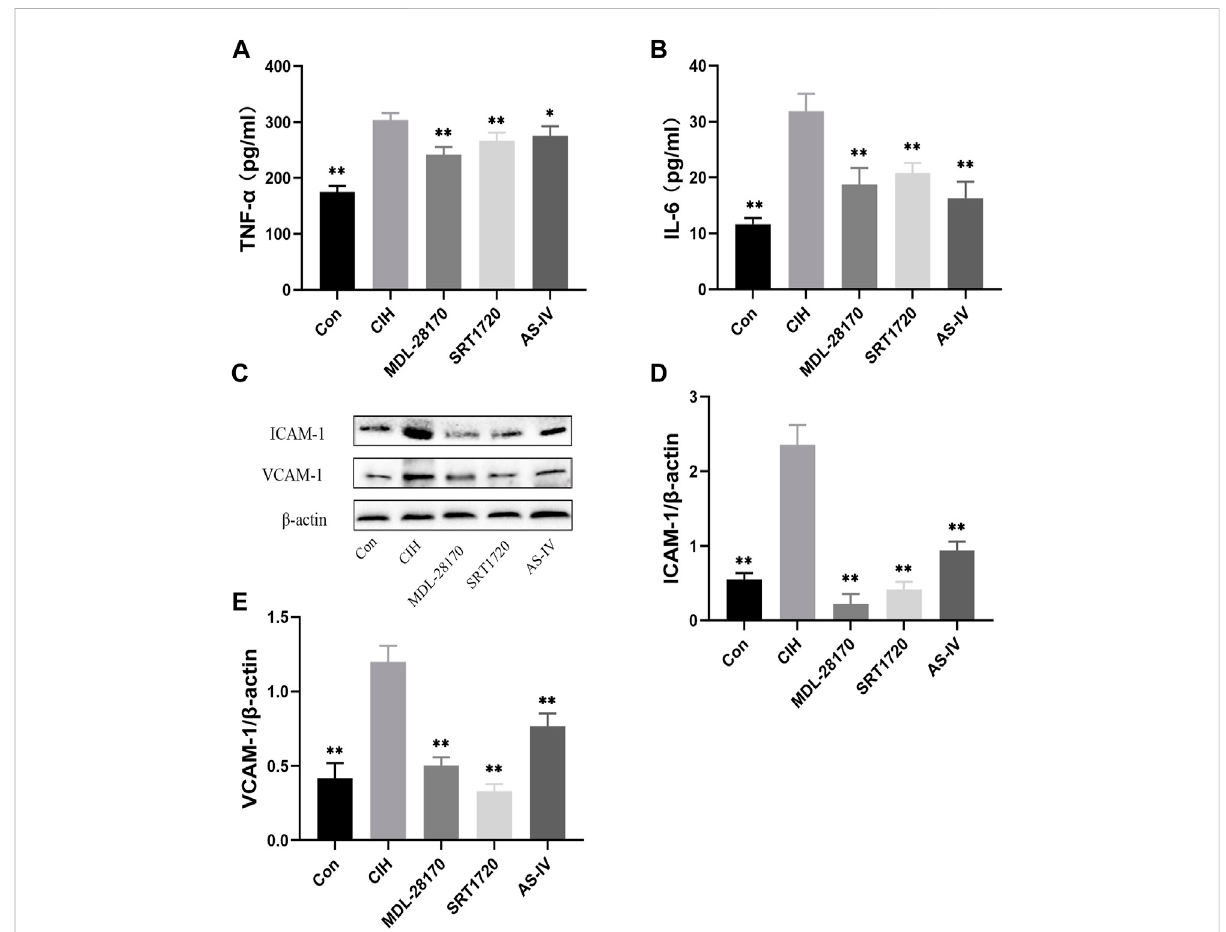
FIGURE 8 Effects of As-IV, MDL-28170 and SRT1720 on in fl ammation in HCAECs. (A,B) The levels of TNF- α and IL-6 was detected using ELISA ( n = 8). (C – E) The levels of VCAM-1 and ICAM-1 were measured using Western blot ( n = 3). Data are presented as means ± SD. ** p < 0.01, vs. CIH